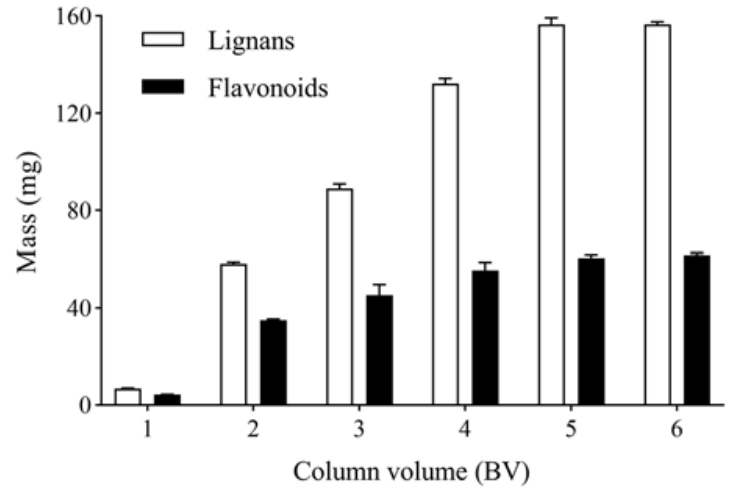
Figure 4. Effect of eluent volume on mass of total lignans and flavonoids from V. amurensis extract.